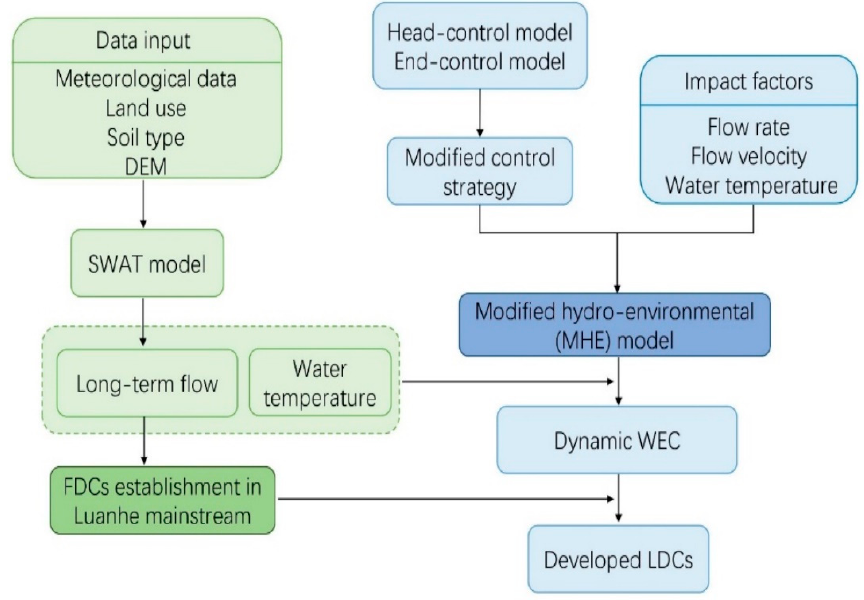
Figure 2. Flowchart of integrated estimation method based on a modified hydro-environmental (MHE) model and load–duration curve method.